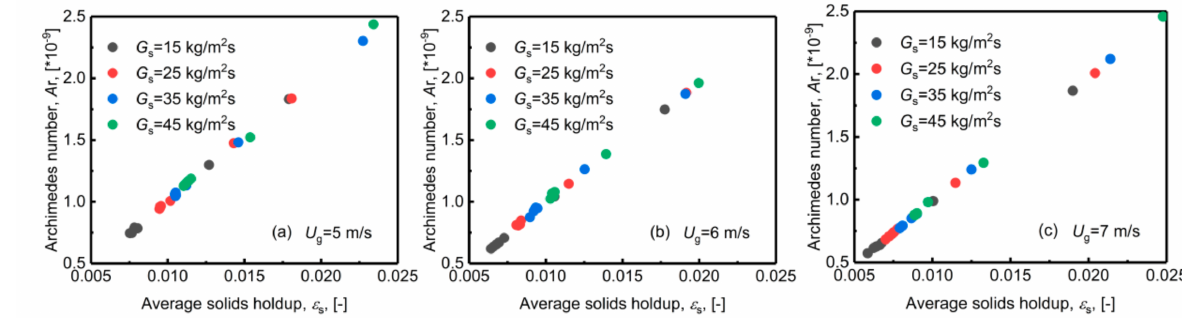
Figure 10. Archimedes number under various operating conditions. (( a – c ) represents the relationship between Archimedes number and solids holdup under the gas velocity of 5, 6 and 7 m/s,